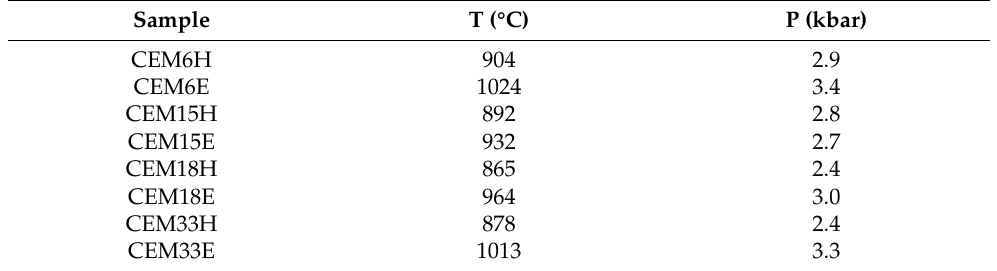
Table 4. Estimated temperature and pressure for the studied clinopyroxenes on the basis of geochemistry.